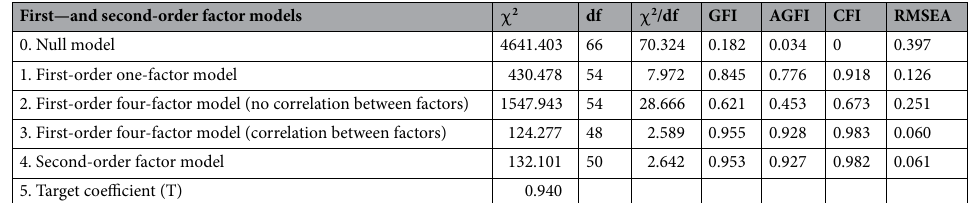
Table 5. The goodness-of-fit indexes for work quality, first-order and second-order factor models. GFI goodness-of-fit index, AGFI adjusted GFI, CFI comparative fit index, RMSEA root mean square error approximation. Target coefficient (T) = Chi-square value for first-order four-factor model (factors are correlated)/chi-square value for second-order four-factor model; χ 2 test = Chi-square test.